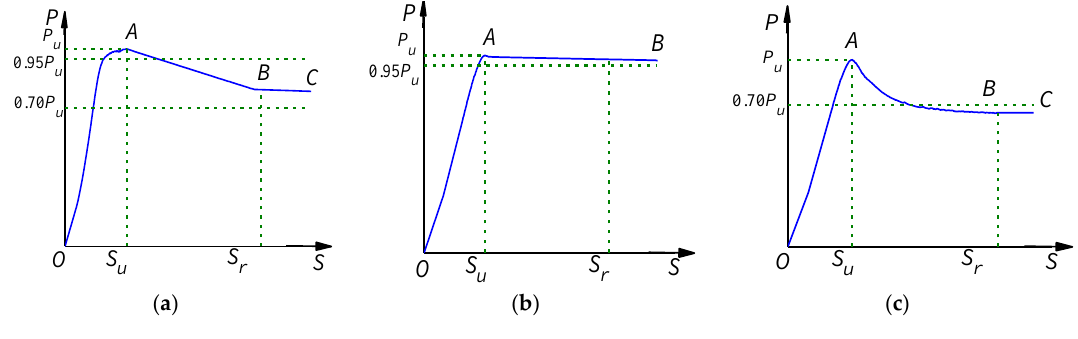
Figure 11. Typical curve classification ( a ) I ; ( b ) II ; ( c ) III.